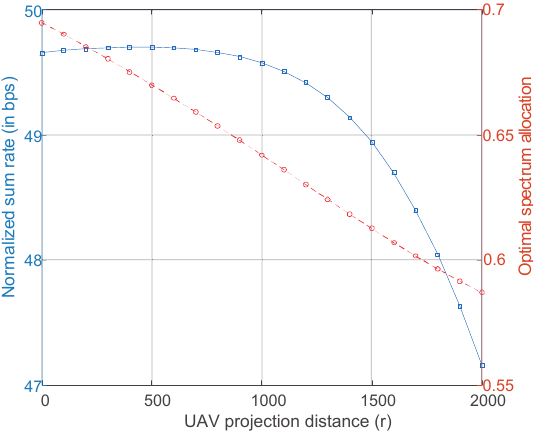
Figure 6. Normalized sum-rate and optimal spectrum allocation versus UAV’s projection